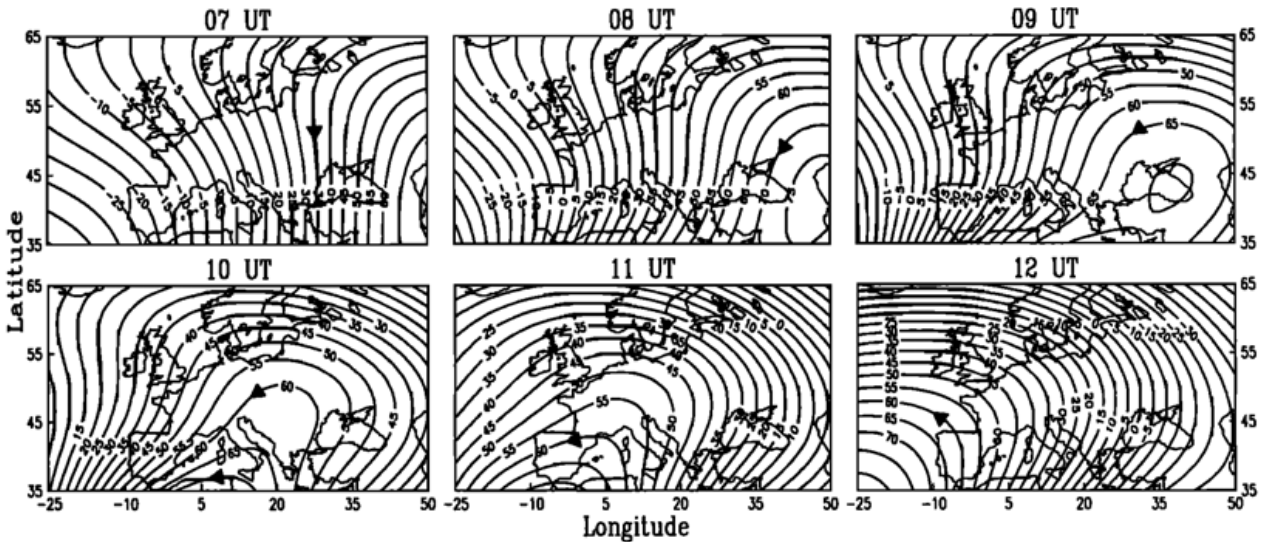
Fig. 12. Equivalent current function contours on 21 April 1987, in the European region for various Universal times – from Torta et al. (1997).